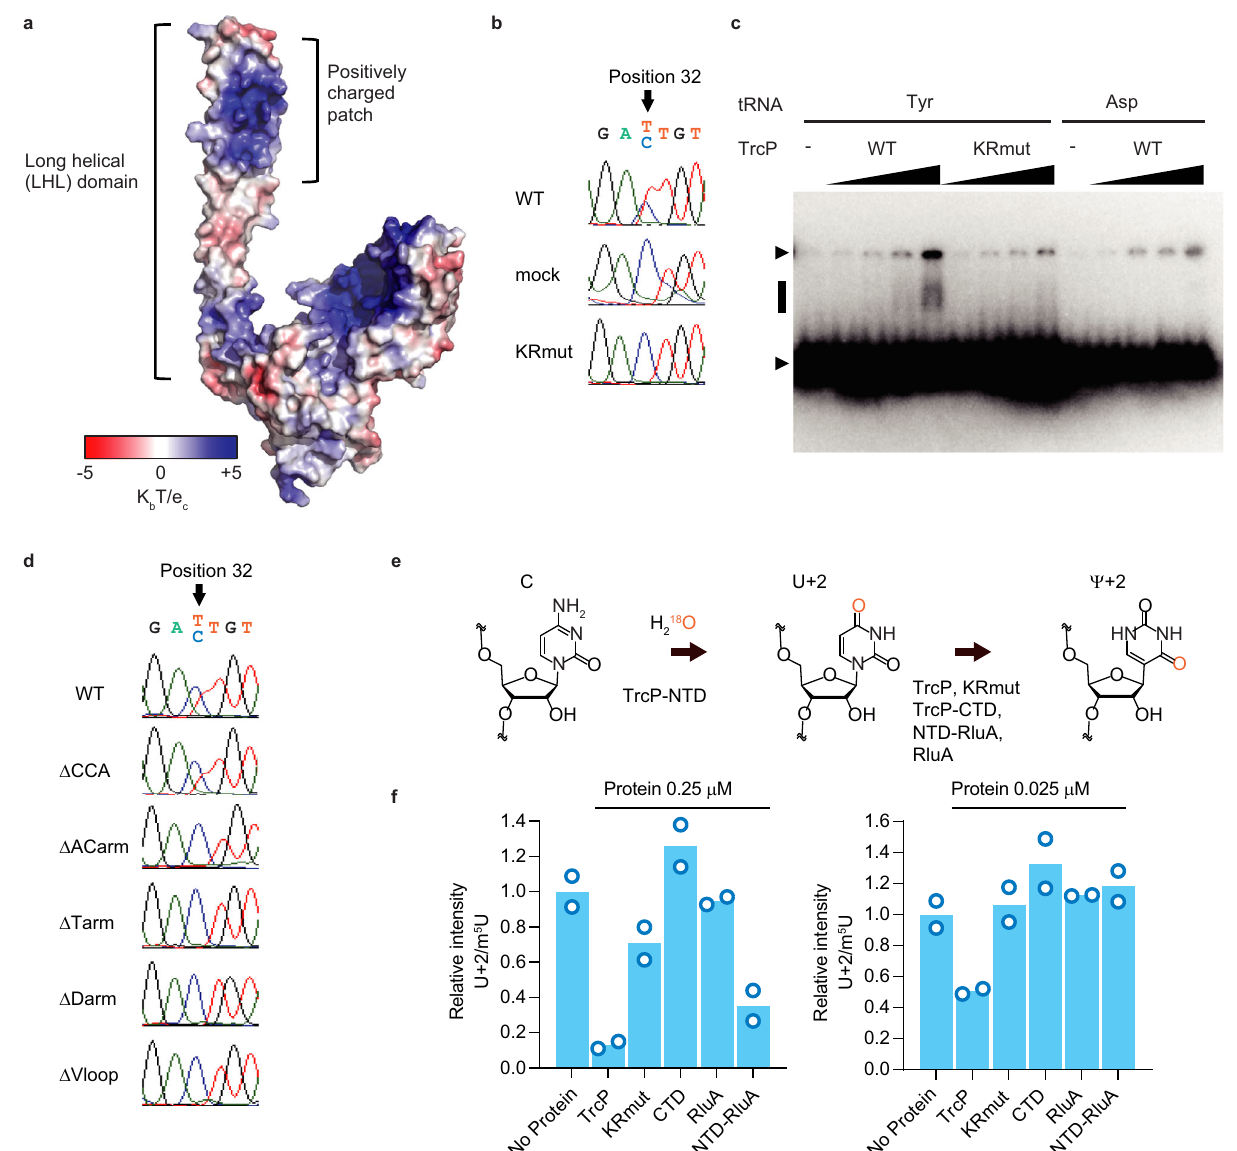
Fig. 4 | The long helical domain facilitates substrate tRNA binding. a Predicted surface electrostatic potential of the structural model of TrcP. The color key is shown below (unit K b T/e c ). b In vivo complementation analysis of the KR mutant. Sanger sequencing results of tRNA-Tyr cDNA derived from RNA isolated from trcP knockout strains expressing TrcP (WT) or mutant derivatives. c Gel mobility shift assay with TrcP (WT and KR mutant) and tRNAs (tRNA-Tyr and tRNA-Asp). Upper andlowerarrowheadsrepresentwellsandfreetRNAsignals,respectively.Theblack line indicates the shifted band, presumably representing the soluble tRNA-TrcP complex. Protein concentrations were 0, 0.1, 1, 2, and 5 μ M, and the tRNA con- centrationwas1 μ M.AnuncroppedblotisprovidedinSourceData.Representative data from two independent experiments with similar results is shown. d Sanger